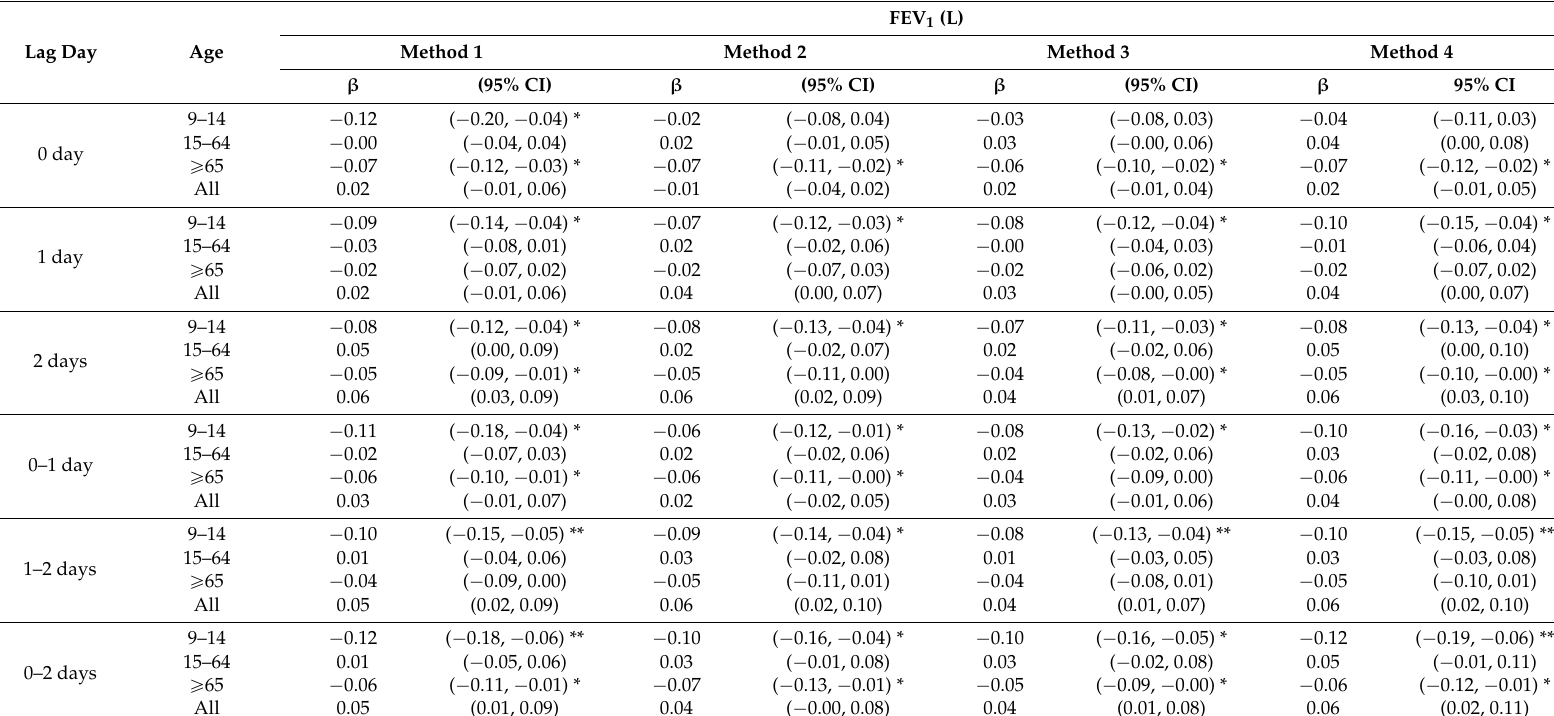
Table 6. Age-specific effect of change in FEV 1 (L) per increase IQR † of O 3 concentration by various lags and four methods for estimating